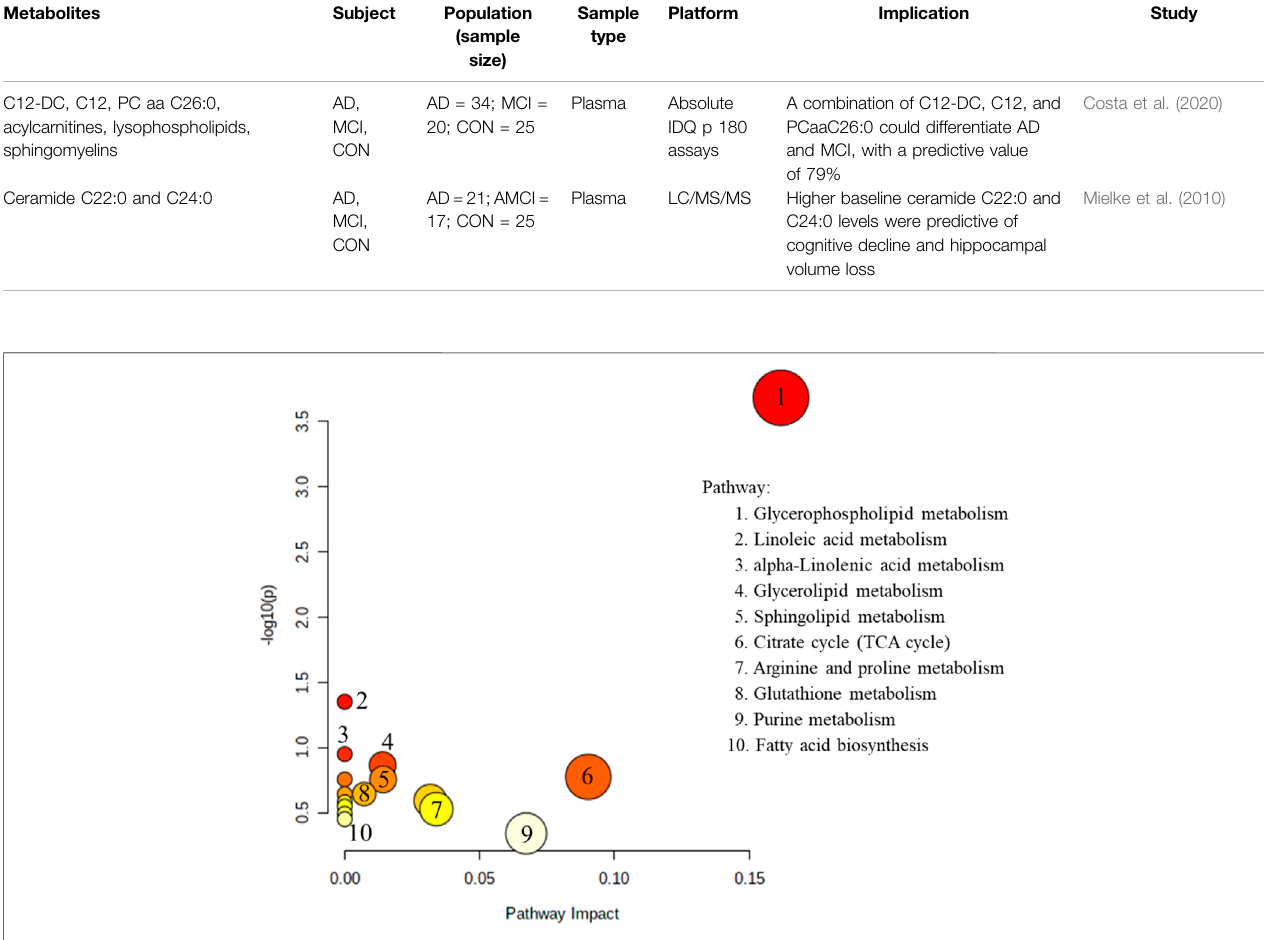
Frontiers in Pharmacology |